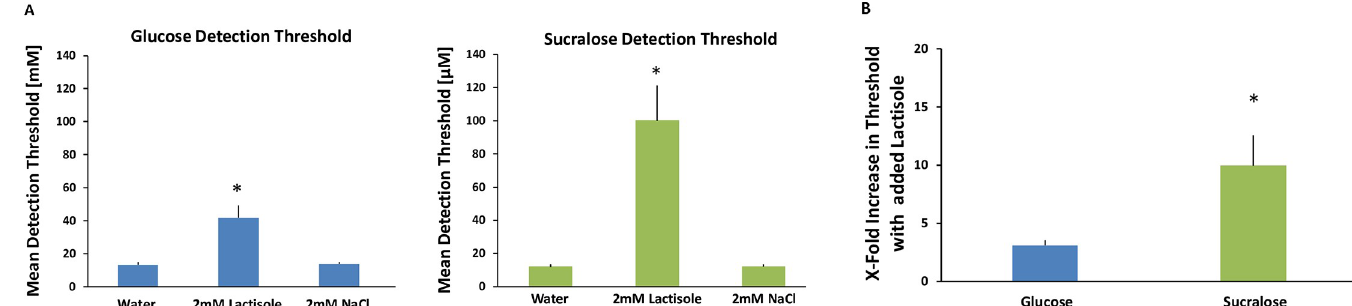
Fig 1. A. Detection thresholds for glucose [mM] and sucralose [ μ M] with and without Na-lactisole. There are two bar charts in Fig 1A. The chart on the left (blue) shows detection thresholds for glucose. The chart on the right (green) shows detection thresholds for sucralose. Each chart contains three bars. From left to right the bars are: 1) Threshold with no treatment, 2) Threshold with 2mM Na-lactisole, 3) Threshold with 2mM NaCl (to control for sodium present in lactisole). All treatments were paired with water rinses between stimuli. Twelve subjects participated in all conditions in duplicate. The error bars are standard errors of the mean. � indicates a significant difference p < .001. B. Impact of Na-lactisole on glucose and sucralose detection thresholds. The “fold increase” in threshold concentration is shown by taking the threshold concentration when treated with Na-lactisole and dividing it by the threshold concentration when untreated. The bar on the left (blue) represents glucose and the bar on the right (green) represents sucralose. The treatment concentration of Na-lactisole was 2 mM and the untreated condition contained the same level of sodium via the addition of 2 mM NaCl. All treatments were paired with water rinses between stimuli. Twelve subjects participated in all conditions in duplicate. The error bars are standard error of the mean. � indicates a significant difference, p <